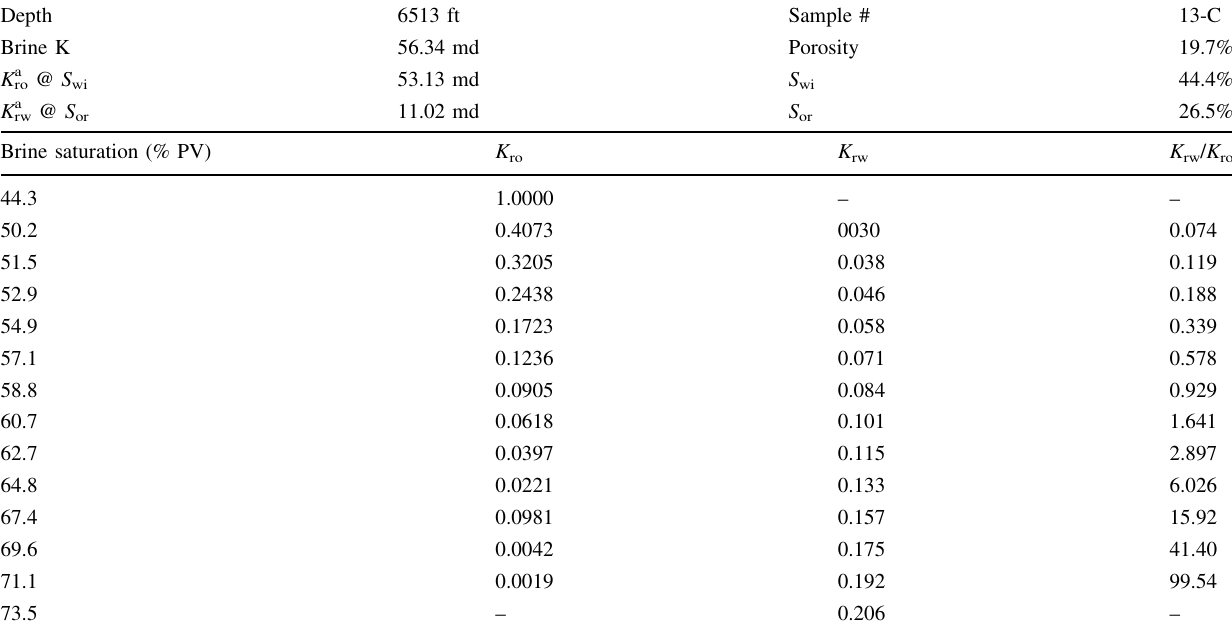
Table 2 Brine/oil relative permeability measured for sample 13-C